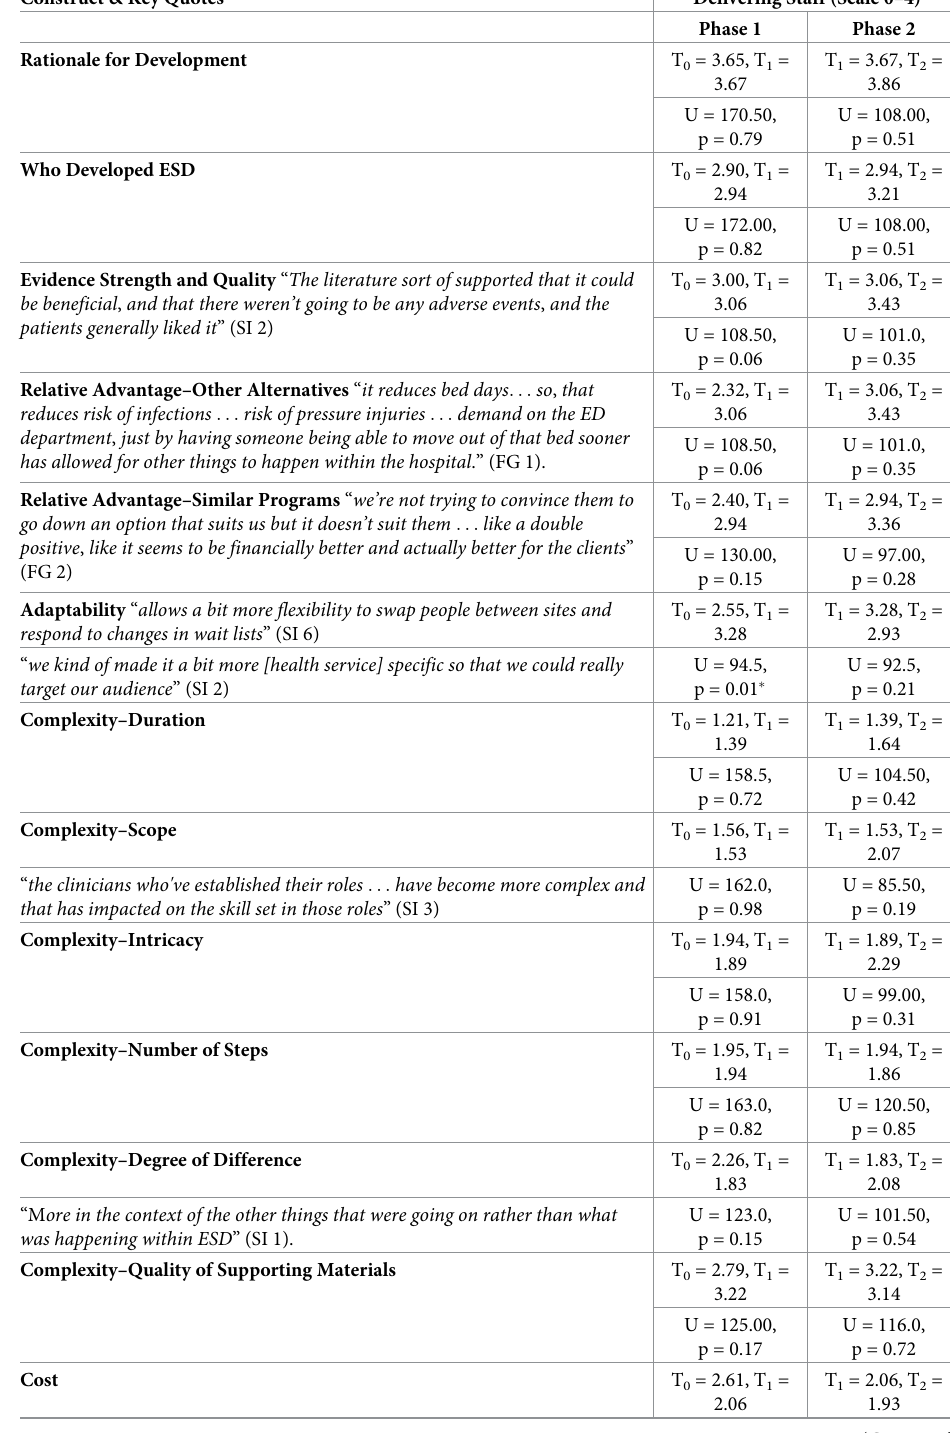
Table 3. Findings for Intervention Characteristics